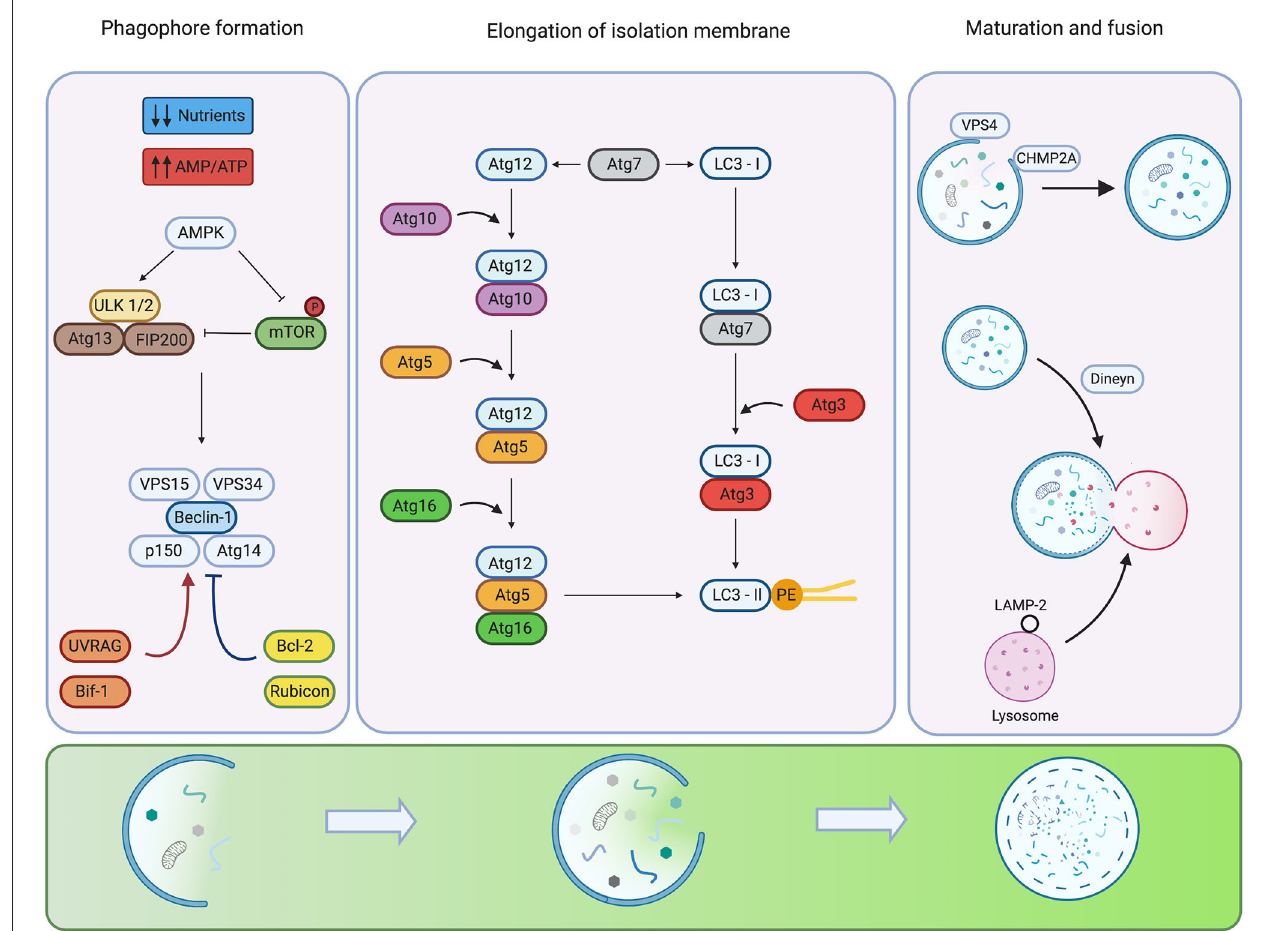
FIGURE 1 | Regulation of the mammalian autophagy. Under low nutrient conditions or starvation, the energy sensor AMPK detects alterations in energy pools (AMP/ATP ratio) inhibiting autophagy repressor mTOR and activating ULK1/2 complex. For phagophore formation, ULK1/2 complex activates the Beclin-1 P13K-class III complex. Additional systems activate (red arrows) or inhibit (blue arrows) the activity and assembly of the complex. The elongation of the isolation membrane requires the participation of two ubiquitin-like conjugation systems. The formation of the Atg12-Atg5-Atg16 complex involves the activity of Atg7 and Atg10. The LC3 requires the participation of Atg4 to hydrolyze LC3 into LC3-I, Atg3 as well as Atg7 for conjugation of LC3-II to pohosphatidyletanolamine (PE). Phagophore closure is regulated by members of ESCRT, CHMP2A VPS4. In the late steps of maturation and fusion, Dynein participates in the mobilization of auto phagosomes. The fusion of auto phagosomes with lysosomes is mediated by members of the SNARE family. Created by